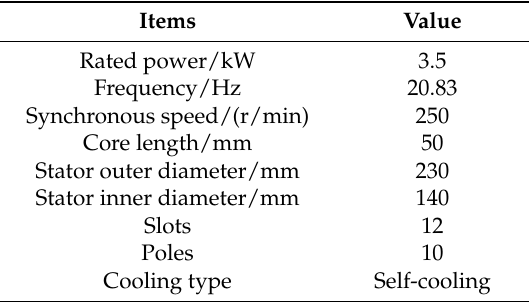
Figure 2. Basic structure of the prototype. 1-Enclosure, 2-Stator Core, 3-Armature Windings, 4-Outer Ferromagnetic Ring, 5-Inner Ferromagnetic Ring, 6-Rotor Core, 7-Shaft. Table 1. Design parameters of the prototype.